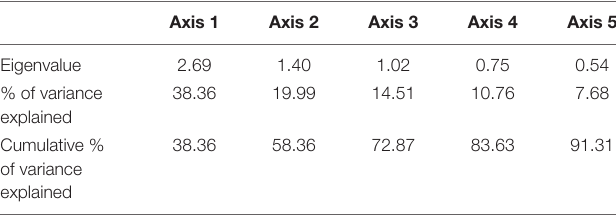
TABLE 4 | Eigenvalues and the explained variance and cumulative variances of the principal components limited to 5 axes for oil sardine environmental data in southeastern Arabian Sea.